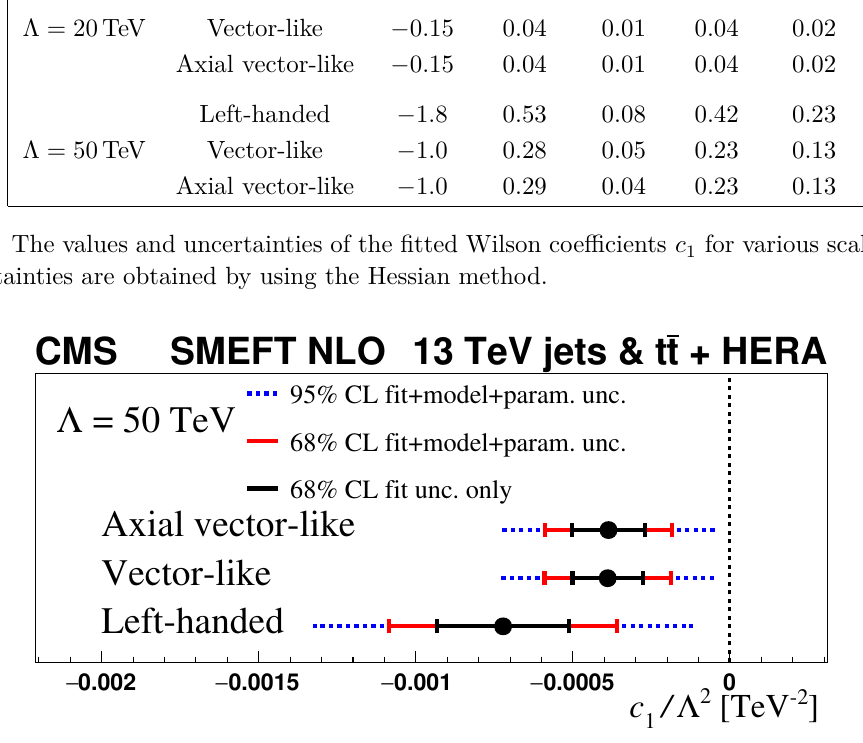
obtained in the SMEFT analysis at NLO, divided by Λ 2 , Figure 19 . The Wilson coefficients c 1 for Λ = 50 TeV. The solid (dashed) lines represent the total uncertainty at 68 (95)% CL. The inner (outer) error bars show the fit (total) uncertainty at 68%